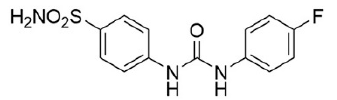
Figure 1. The chemical structure of SLC-0111 .